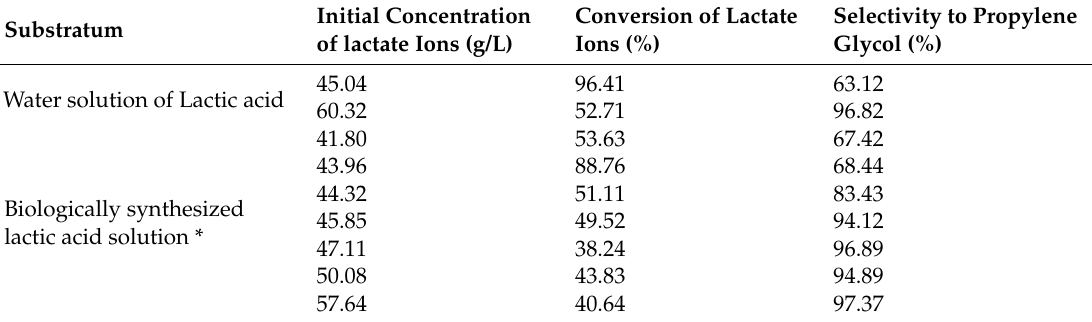
Table 5. Activity and selectivity of 5% Ru/C catalyst during reduction of lactate ions to propylene glycol. Initial Concentration Conversion of Lactate Selectivity to Propylene Substratum of lactate Ions (g/L) Ions (%) Glycol (%) 45.04 96.41 63.12 Water solution of Lactic acid 60.32 52.71 96.82 41.80 53.63 67.42 43.96 88.76 68.44 44.32 51.11 83.43 Biologically synthesized 45.85 49.52 94.12 lactic acid solution * 47.11 38.24 96.89 50.08 43.83 94.89 57.64 40.64